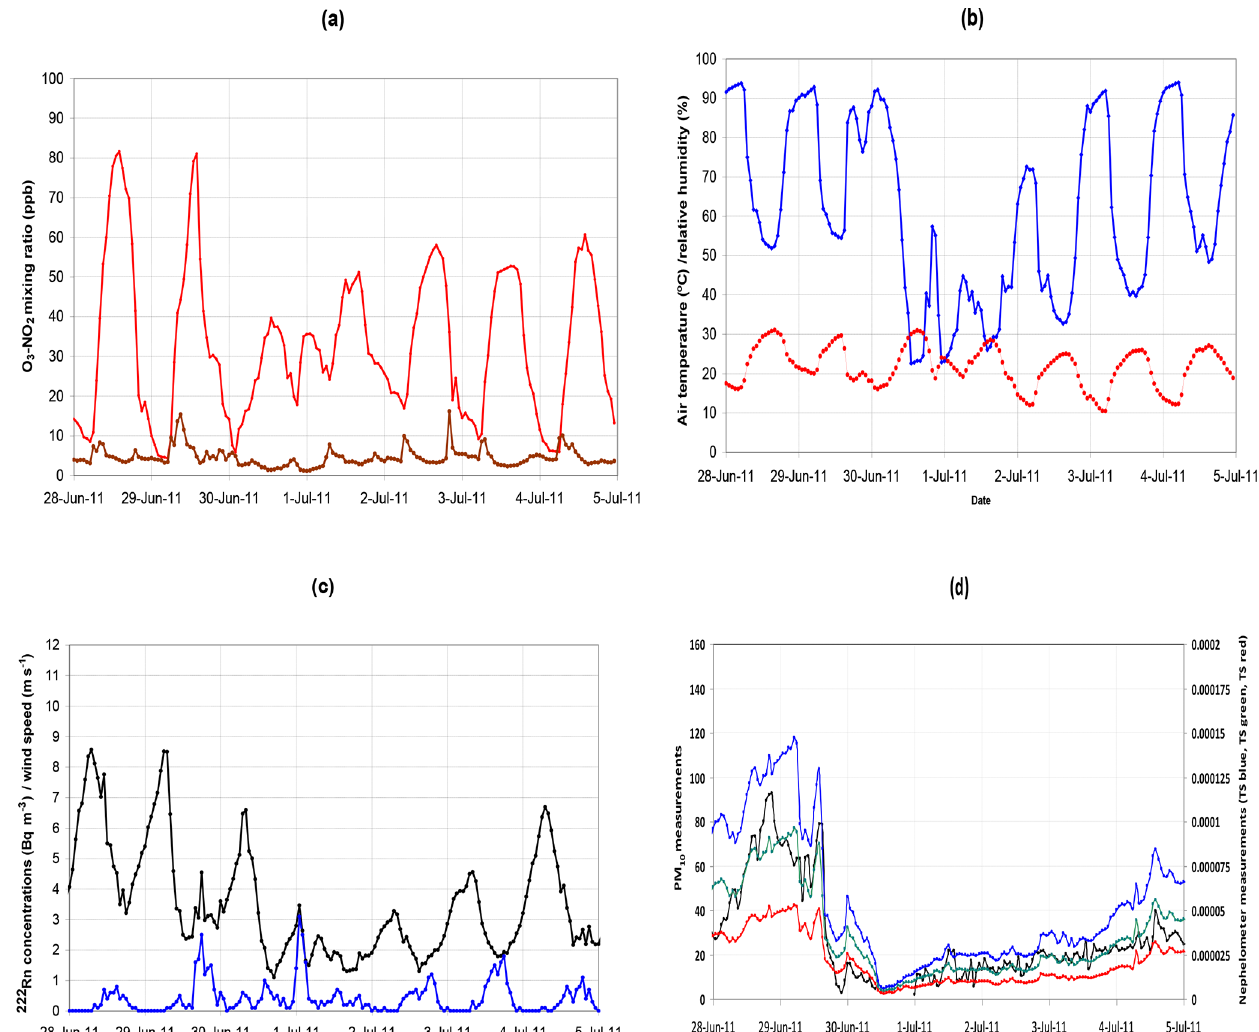
Figure 13. Air pollution and meteorological measurements for 28 June–4 July 2011 at JRC Ispra, Italy. (a) Hourly ozone (red) and nitrogen dioxide (brown) mixing ratios. (b) Hourly relative humidity (blue) and temperature (red) measurements. (c) Hourly 222 Rn concentrations (Bqm − 3 , black) and wind speed (ms − 1 , blue) for 28 June–4 July 2011 at JRC Ispra, Italy. (d) Hourly PM 10 (black, µgm − 3 ) and neph- elometer (in blue, green and red) measurements (m − 1